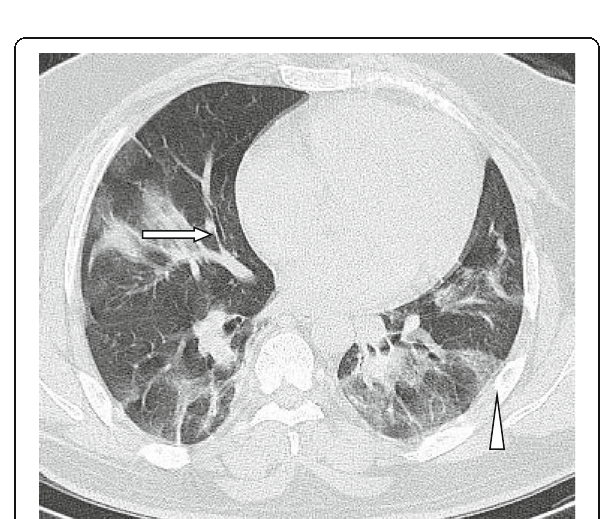
Fig. 21 Mild bronchial dilatation, bronchial wall thickening (arrow). Note the presence of spider web sign in the left lower lobe (arrow